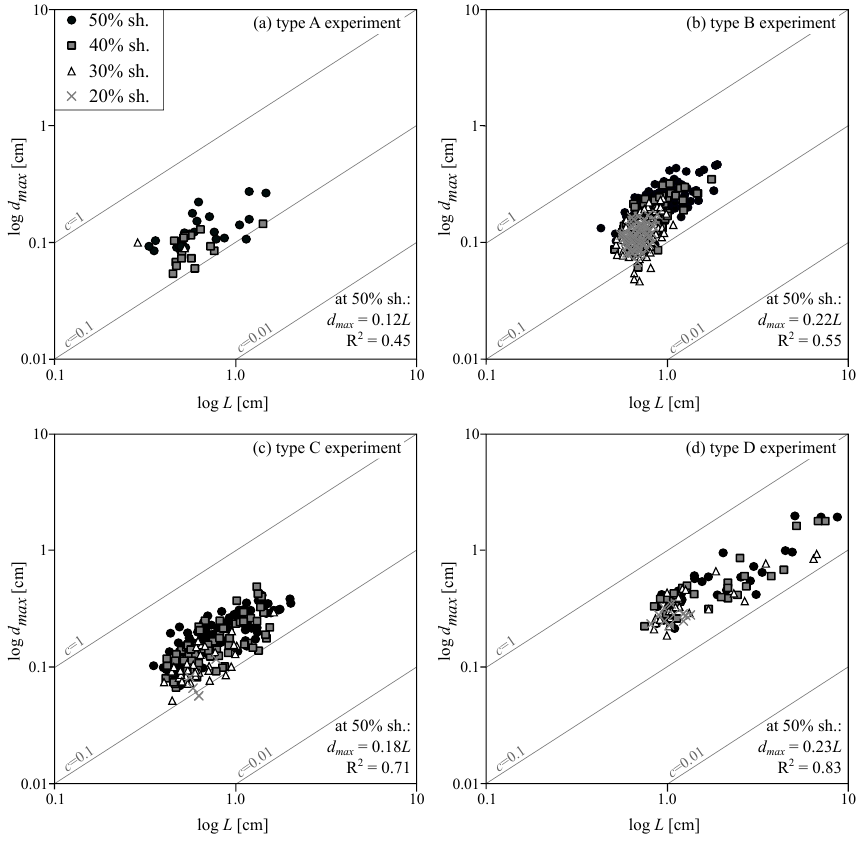
Figure 9. Log maximum fracture length ( d max ) vs. log maximum fracture displacement ( L) graphs for models (a) type A, (b) type B, (c) type C and (d) type D. Data correspond to shear fractures measured at 20, 30, 40 and 50% of shortening within the sampling area. Grey lines indicate linear relationships in the log–log graph for different c values in Eq.